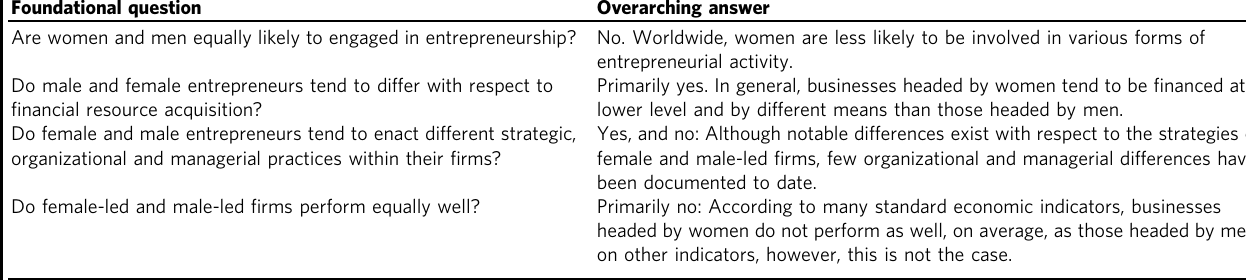
Table 1 Foundational questions, overarching answers and speci fi c illustrative fi ndings within women ’ s entrepreneurship research.